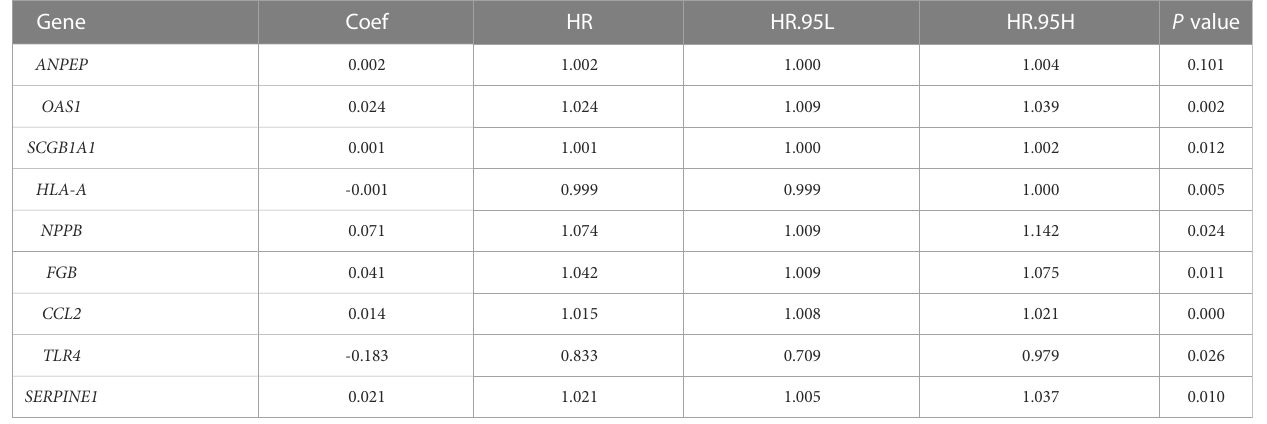
TABLE 3 Results from multivariable Cox regression analysis.